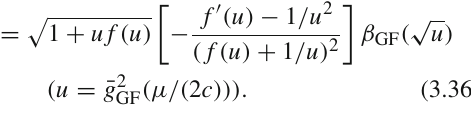
/μ ref from a non-perturbative matching between the GF and SF MS